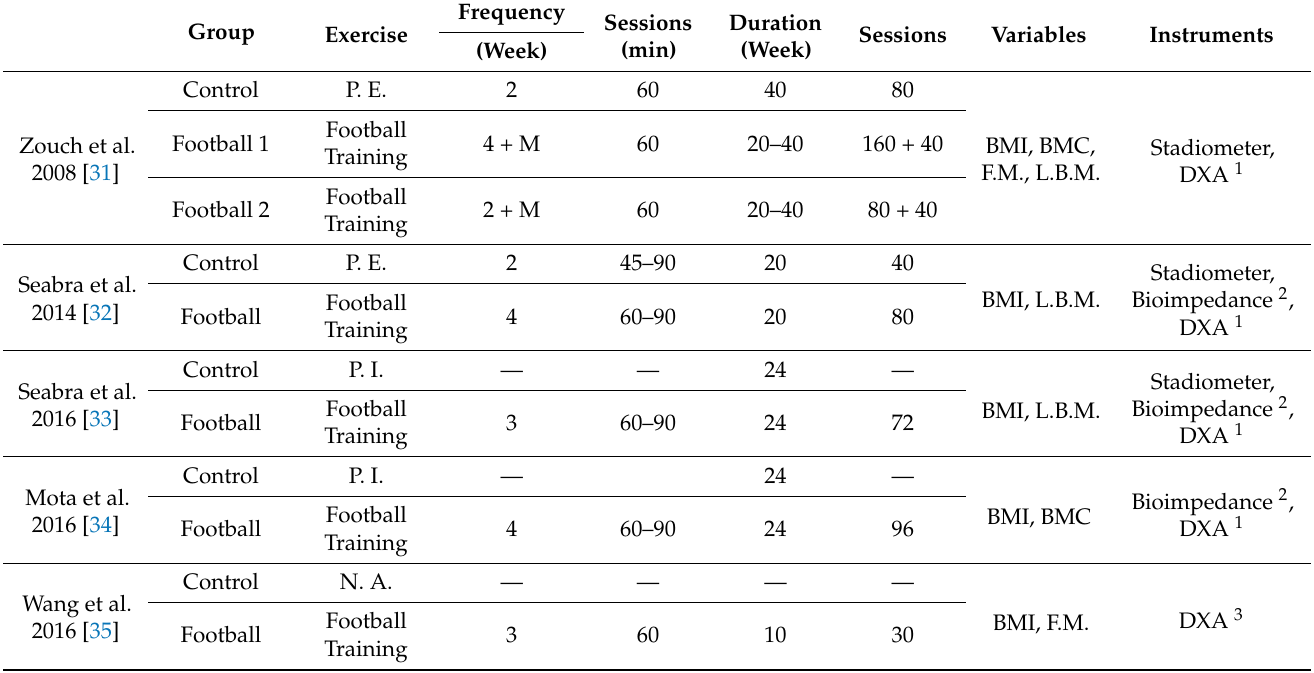
Table 2. General characteristics the studies included in the